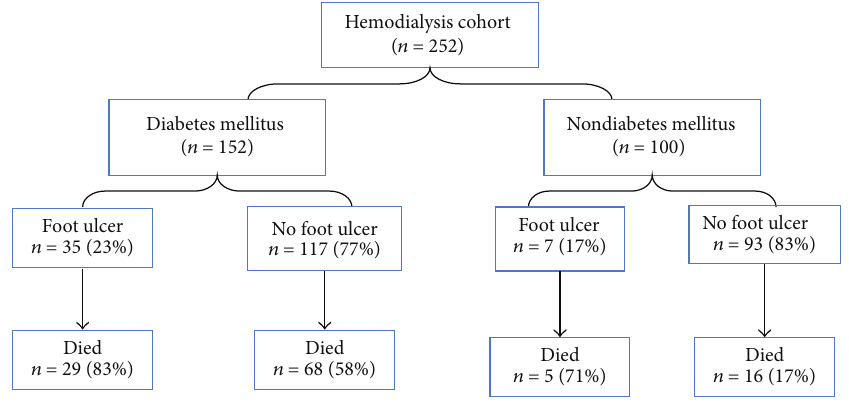
Figure 1: Study flow